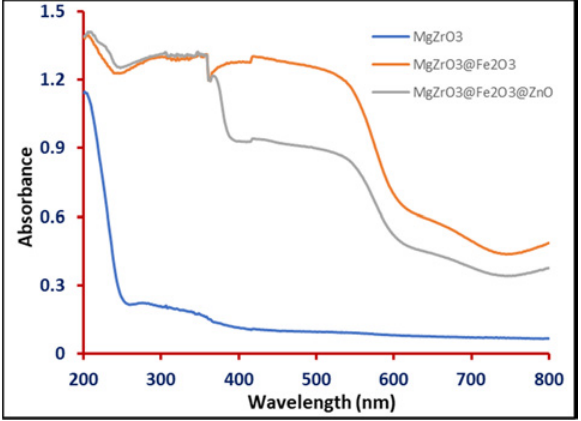
Fig.1. UV-DRS analysis of modified MgZrO